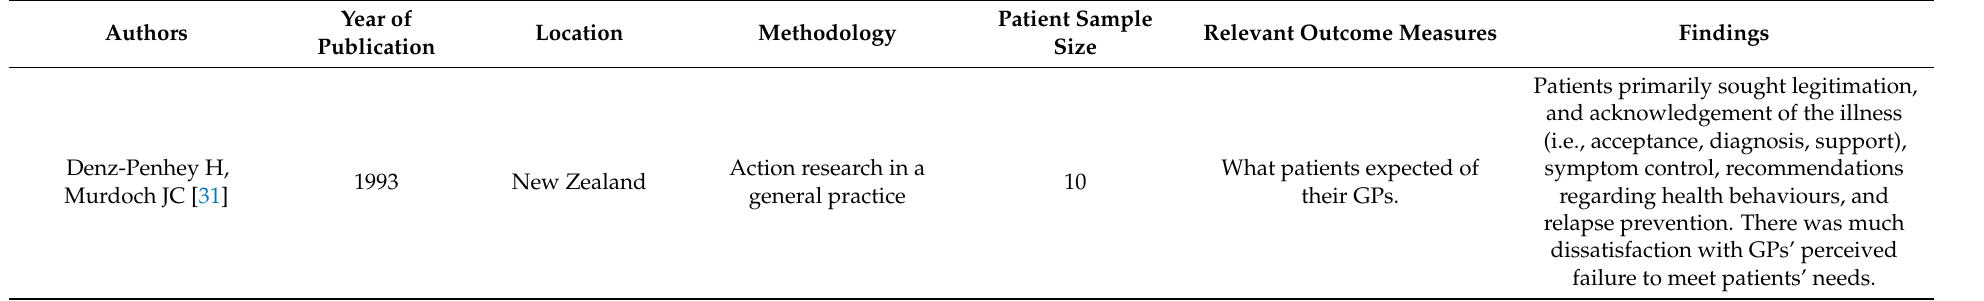
Table 7. Qualitative studies of patients’ views of GPs’ knowledge and understanding of